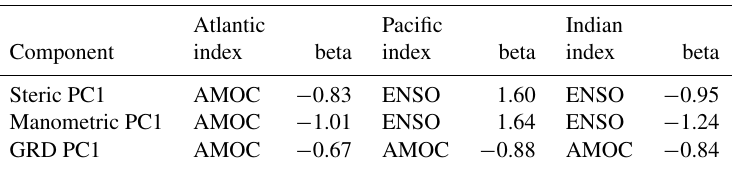
Table 3. The linear trend coefficient between the decadal trend in the climate index and the first PC time series in each basin and for each component of sea